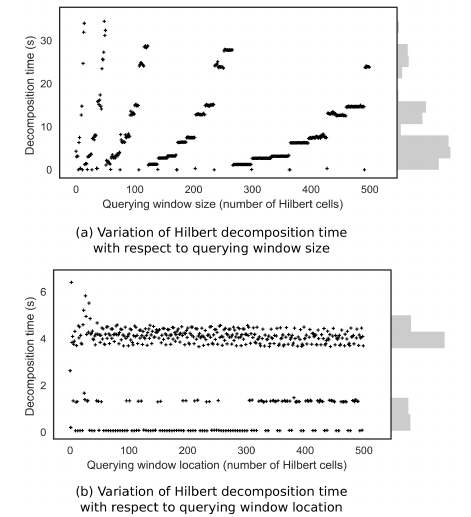
Figure 11. Hilbert decomposition